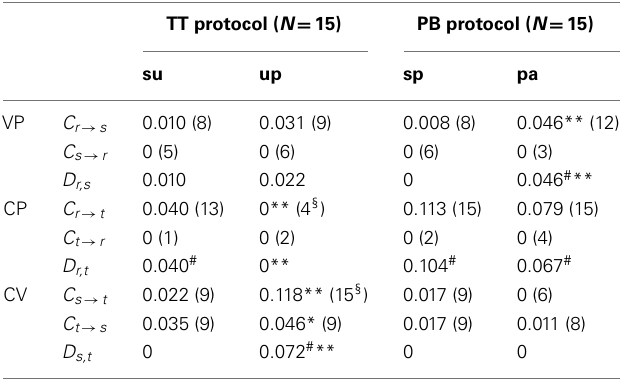
Table 3 | Causal coupling index C and directionality index D computed between respiratory flow ( r ), systolic arterial pressure ( s ), and heart period ( t ) time series measured during the tilt test protocol (TT; su: supine position, up: upright position) and during the paced breathing protocol (PB; sp: spontaneous breathing, pa: paced breathing) in the study of vasculo-pulmonary (VP), cardio-pulmonary (CP), and cardio-vascular (CV) coupling.